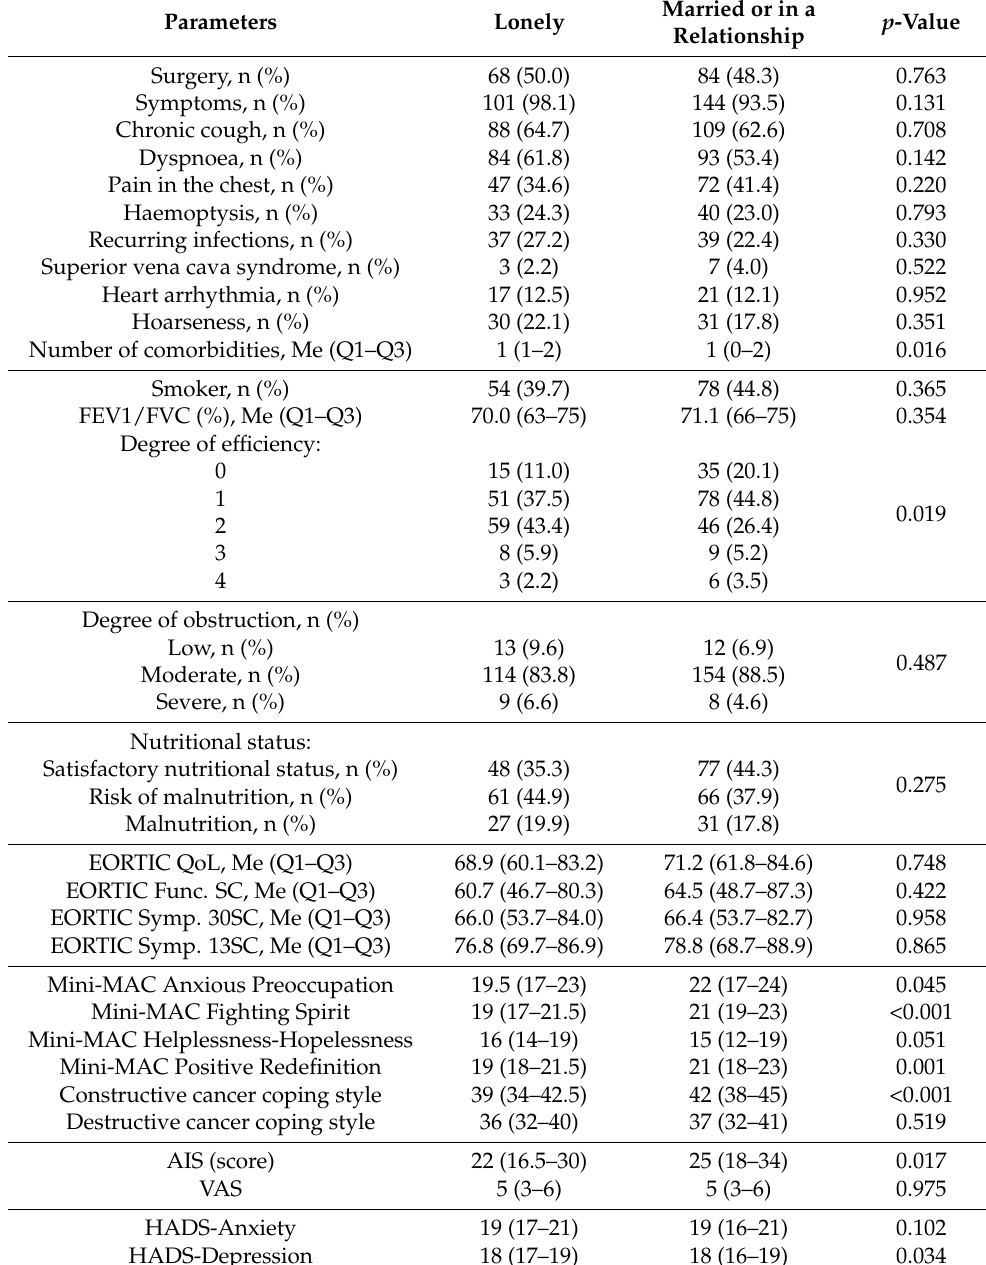
Table 2. Clinical characteristics of 310 patients divided into two groups based on their marital